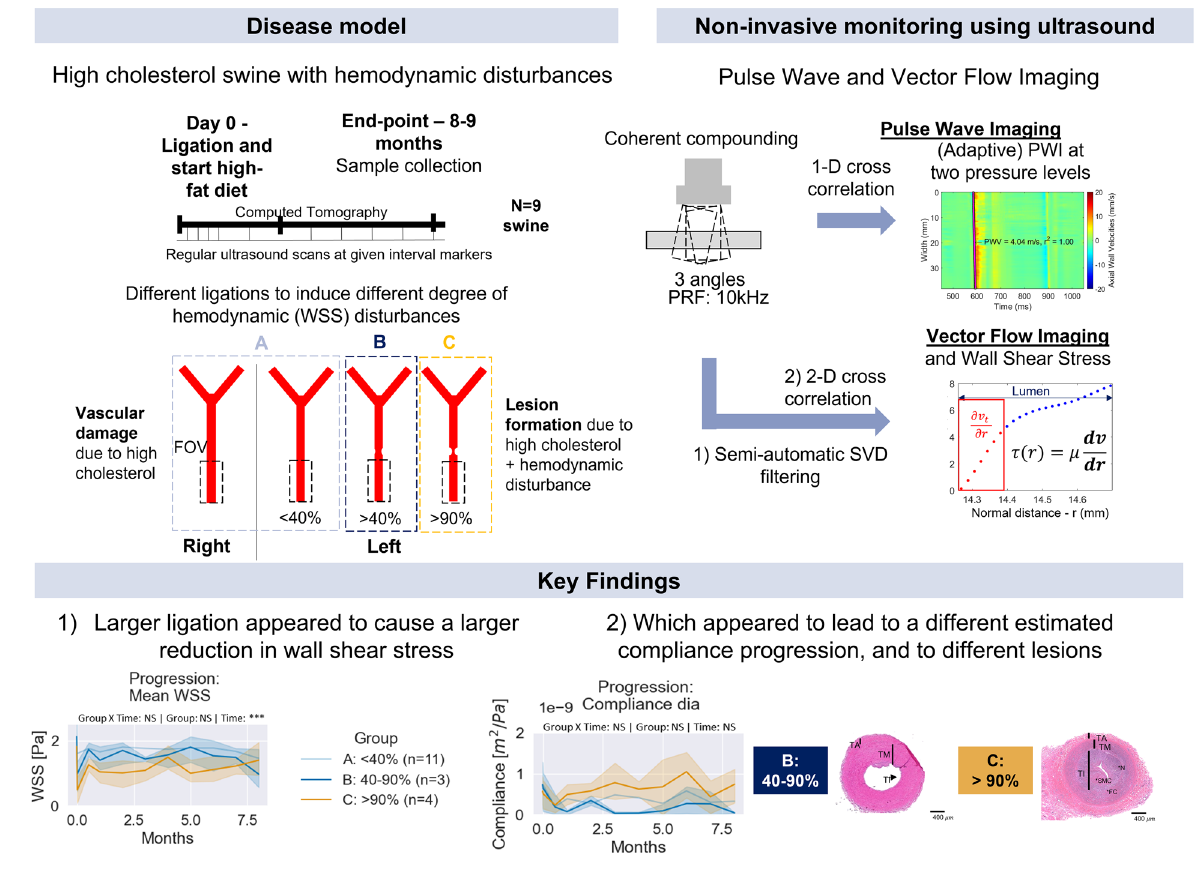
Figure 1. Central figure. A swine model with elevated cholesterol levels was used in this study to simulate the progression of atherosclerotic disease. Various degrees of hemodynamic disturbances were induced in order to accelerate the progression of atherosclerosis and to ensure that it is known where the plaques originate so that it can be monitored. The hemodynamic and stiffness markers were calculated using Pulse Wave and Vector Flow Imaging. The key finding was that a greater ligation appeared to reduce wall shear stress more drastically. This distinct observed hemodynamic disturbance seemed to have resulted in a distinct estimated progression of compliance and distinct lesions.